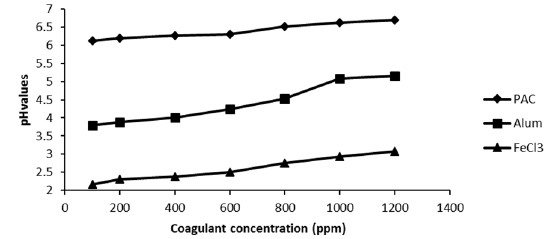
Figure 5: Effects of different PAC, Alum, FeCl3 concentrations (ppm) pH